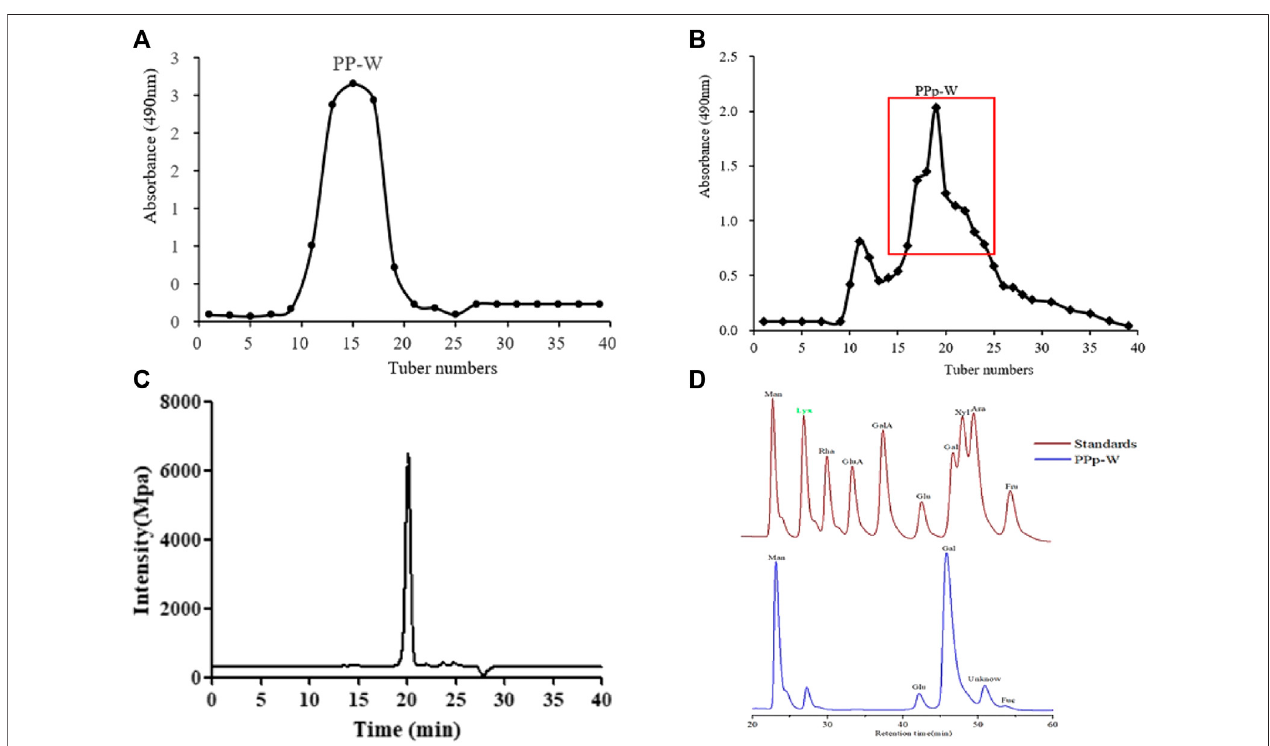
FIGURE 2 | Elution curve of DEAE-52 column chromatography (A) . Elution curve of Sephadex G-100 column chromatography (B) . Homogeneity of PPp-W (C) . Monosaccharide composition of PPp-W (D) .